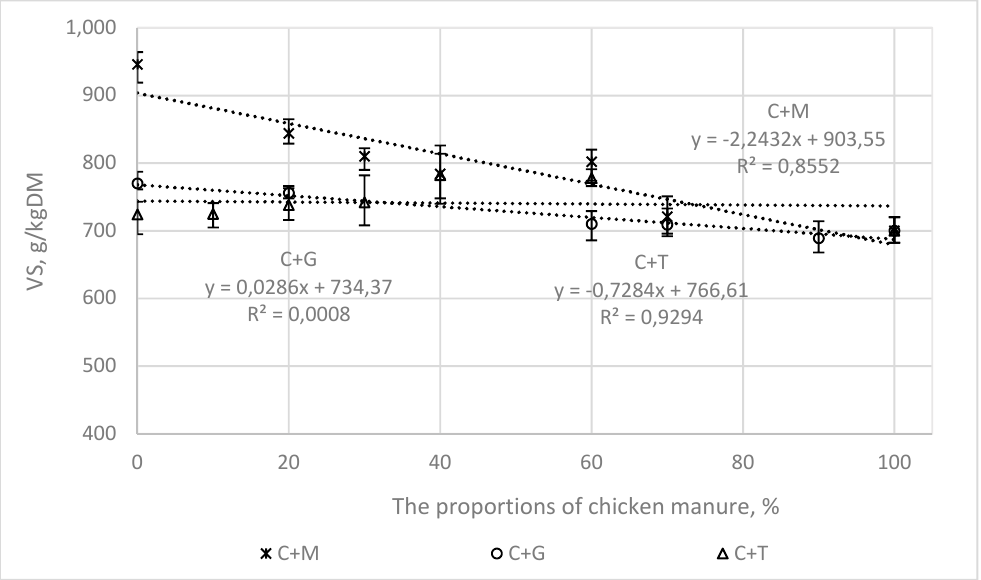
Figure 6. The correlations between VS and the proportions of chicken manure in the mixtures with co-substrates .